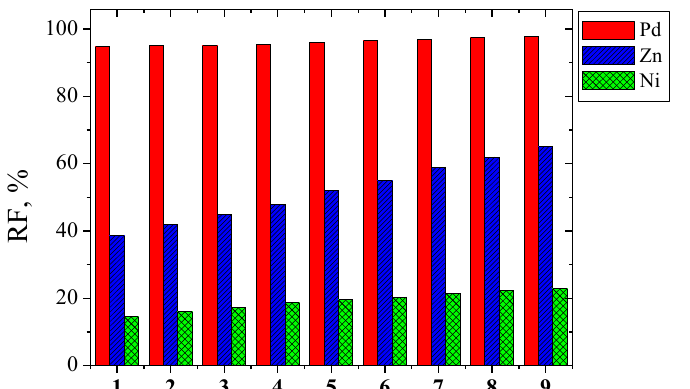
Figure 6. Recovery factor values of Pd(II), Zn(II), and Ni(II) vs. time transport (after 24 h) across PIMs with 1-alkyl-triazoles 1 – 9 .